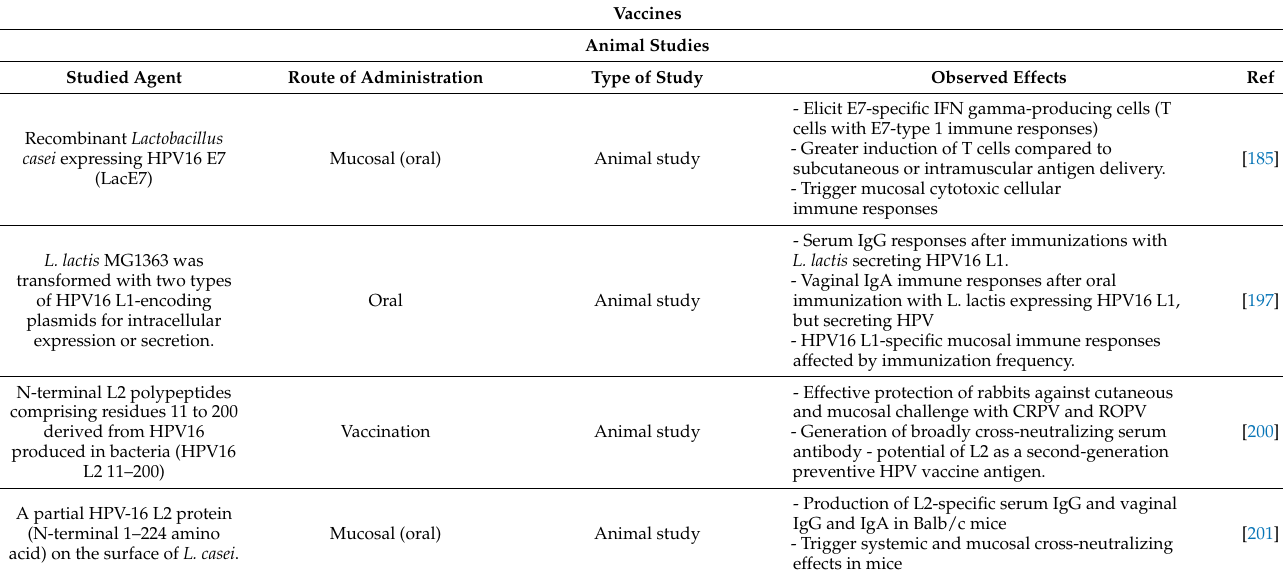
Table 2. Lactic acid bacteria (LAB)-based vaccine